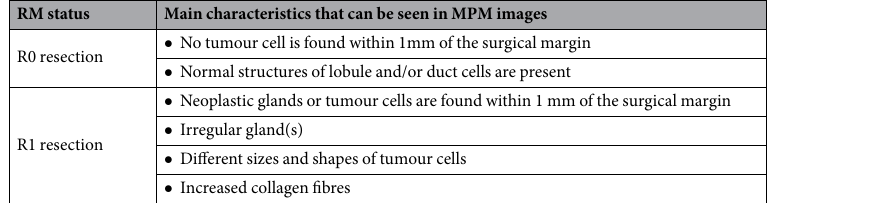
Table 2. Main characteristics of R0 and R1 resections detected by MPM